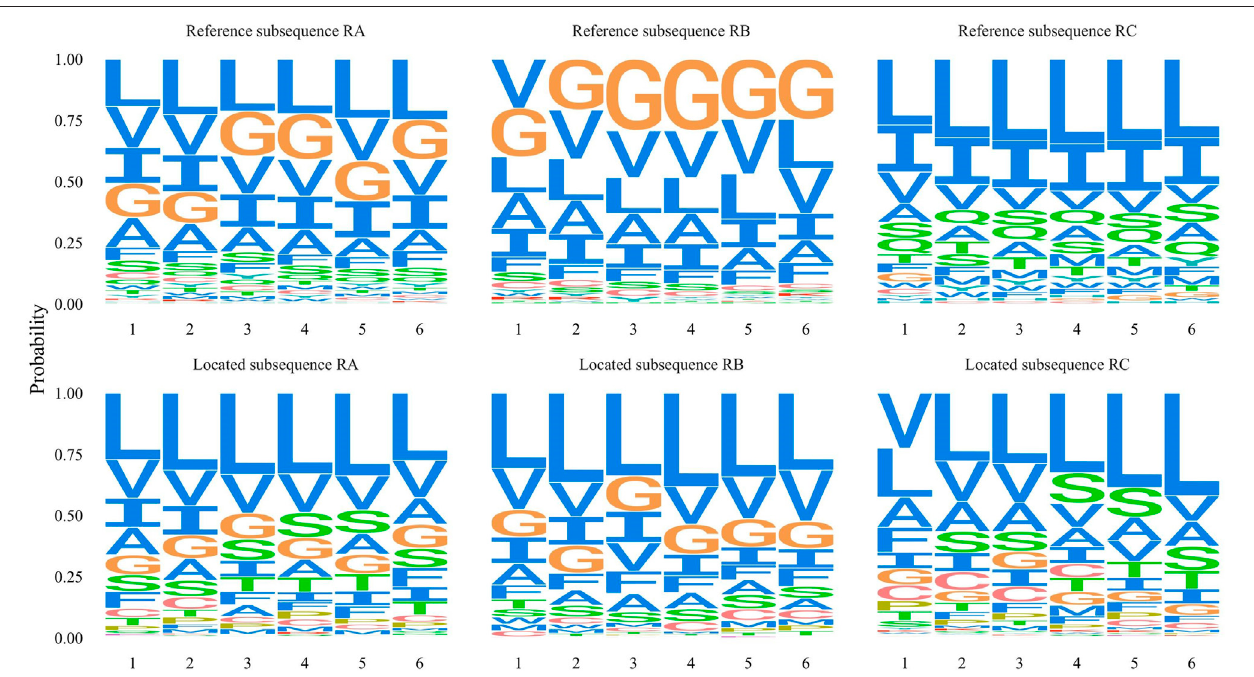
FIGURE 6 | Three contrast experiments respectively used RA, RB, and RC training datasets which include different known motifs information. Corresponding reference subsequence represents the residues frequency of high window score subsequences. The located subsequence represents the frequency of 20 amino acid residues for all located subsequences.